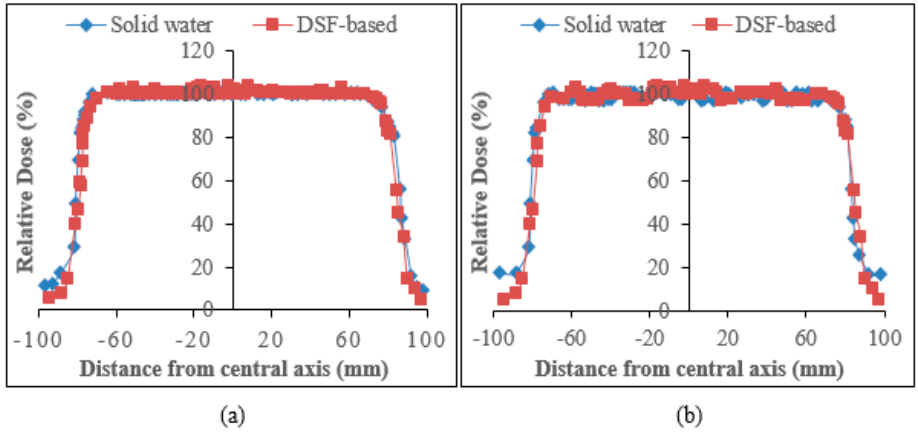
Figure 8. Beam profile for 6 MV photons evaluated at: ( a ) d max and ( b ) d ref .